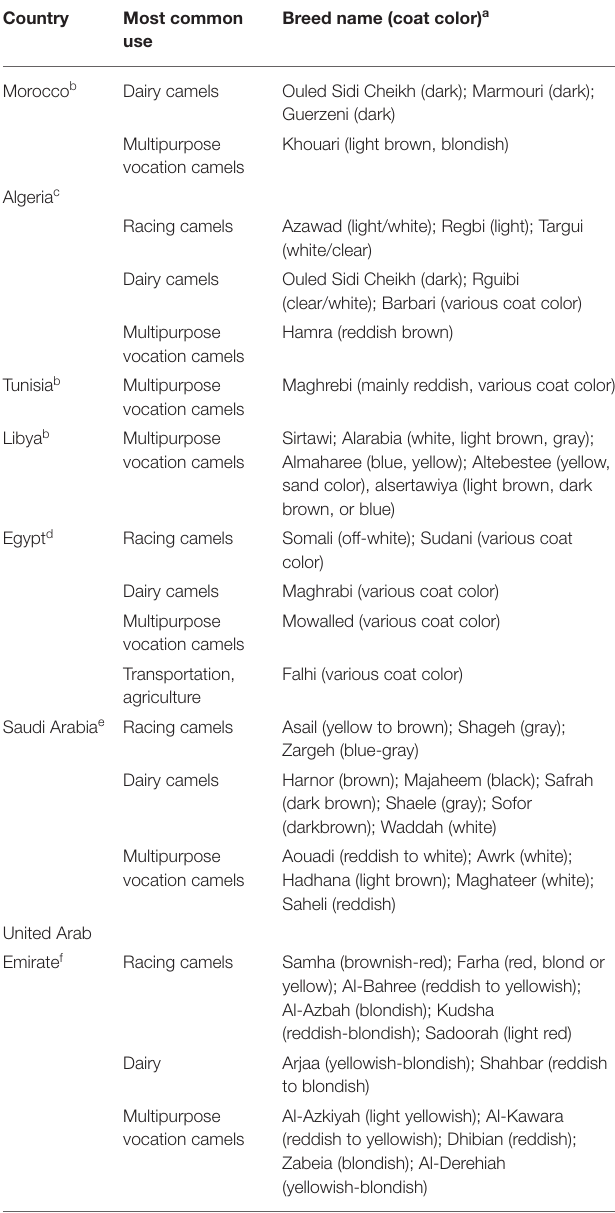
TABLE 6 | Examples of the most popular camel breeds in the North Africa and Arabian